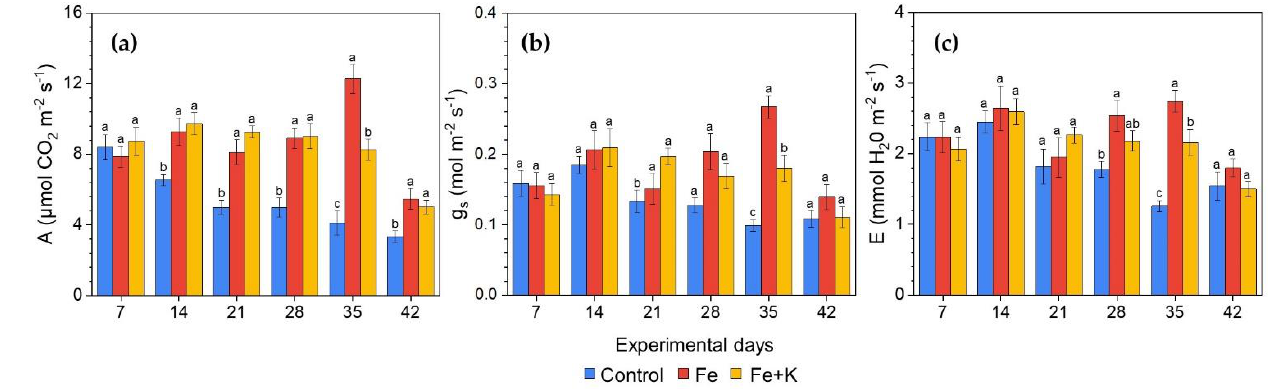
Figure 3. Gas exchange measurements during the experimental period. ( a ) photosynthetic rate (A); ( b ) stomatal conductance (g s ); ( c ) transpiration rate (E) (Mean ± SEM, n = 15). Different letters indicate significant differences among treatments at each experimental day ( p < 0.05).